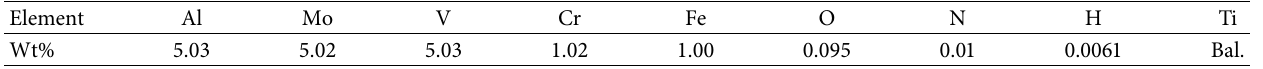
Table 1: The chemical composition of TC 18